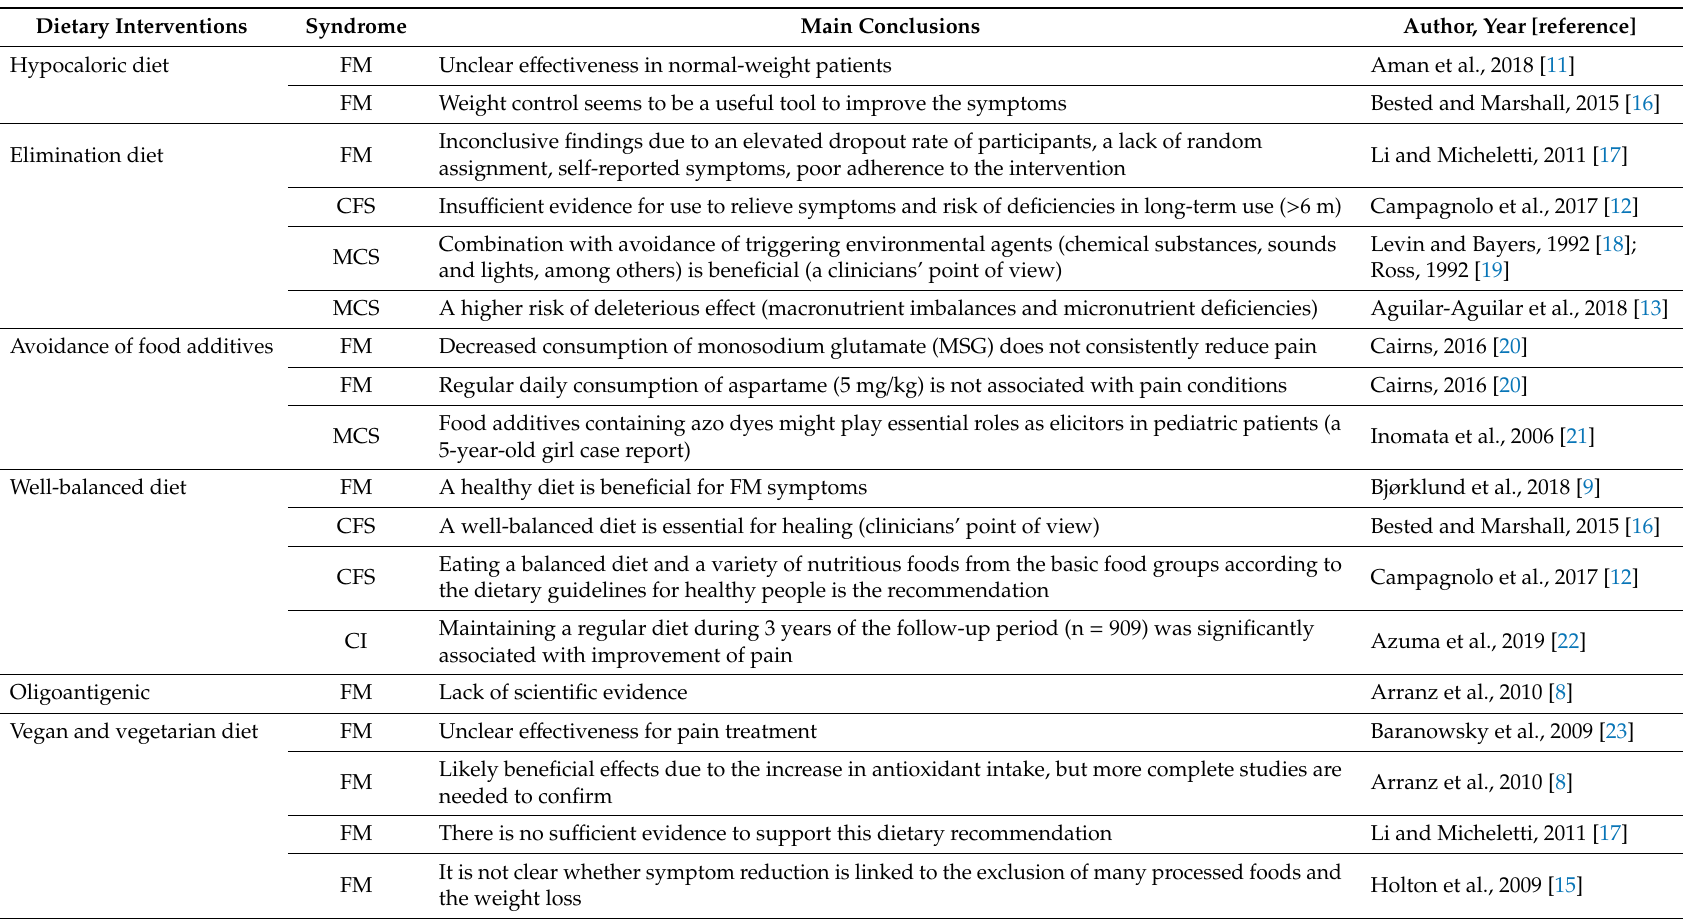
Table 1. Special dietary interventions and main conclusions according to the